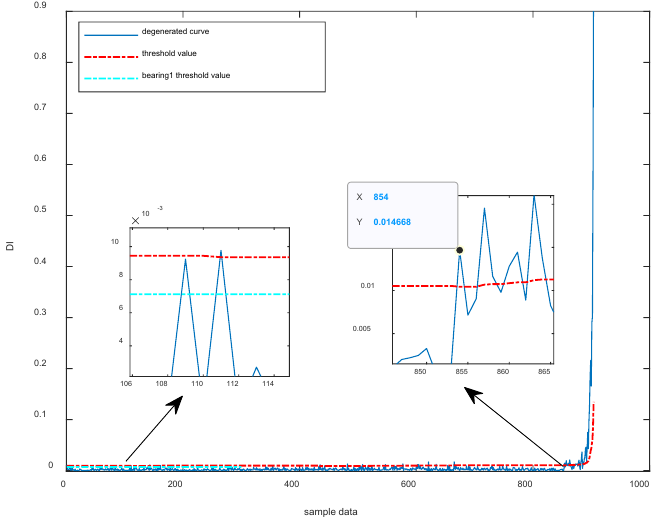
Figure 22. Bearing 3 degradation index based on LLE and SVDD.